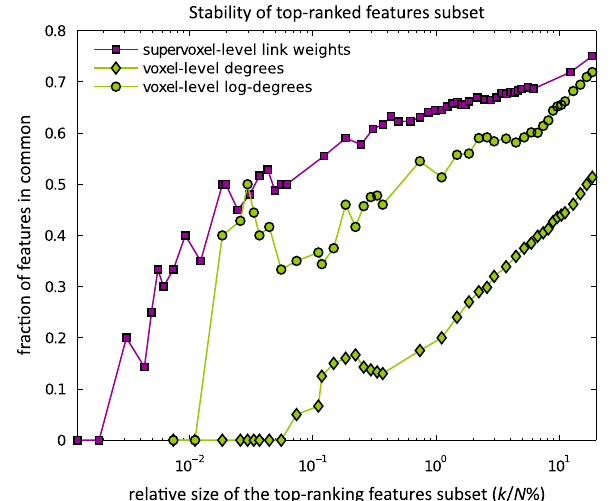
Fig. 2 Stability of feature subset selection over CV-folds. Stability is measured as the fraction of features in common among the subsets of k top features selected in all CV-folds. Plots present the stability of the non-standardized version of the features: degrees, log-degrees, and link-weights described in Methods. The stability rates for the standardized version of log-degree and link-weight features, ss-log- degree and ss-link-weights, were similar to the non-standardized versions presented here and are not displayed